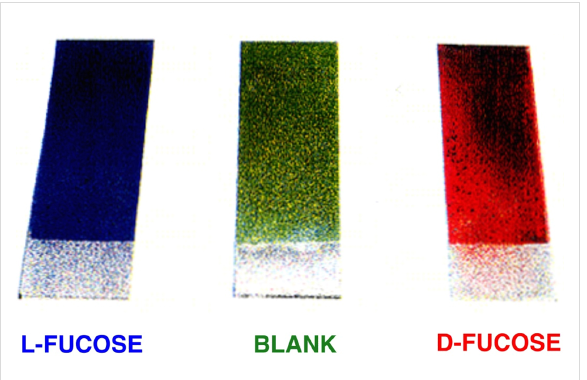
lecture by Sir J. Fraser Stoddart in Halifax (Canada) where he